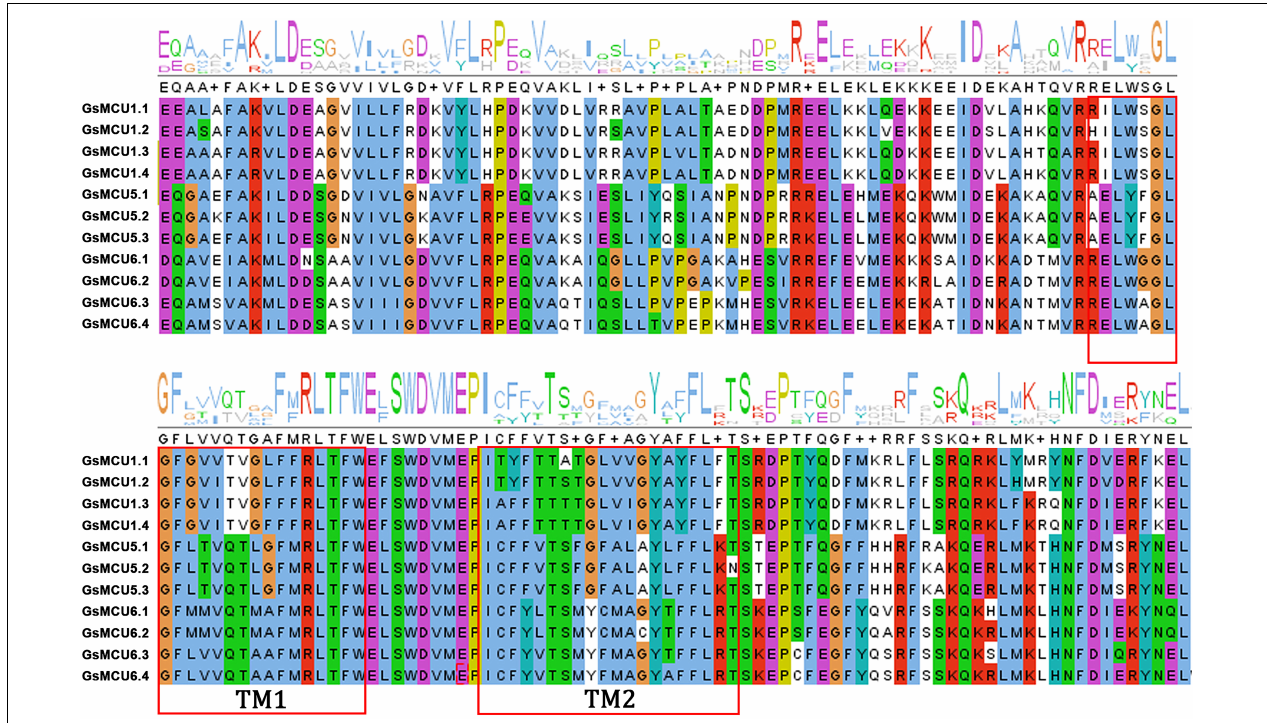
FIGURE 5 | Multiple sequence alignment of the MCU domain within GsMCUs proteins. Two transmembrane regions (TM1 and TM2) are marked by red